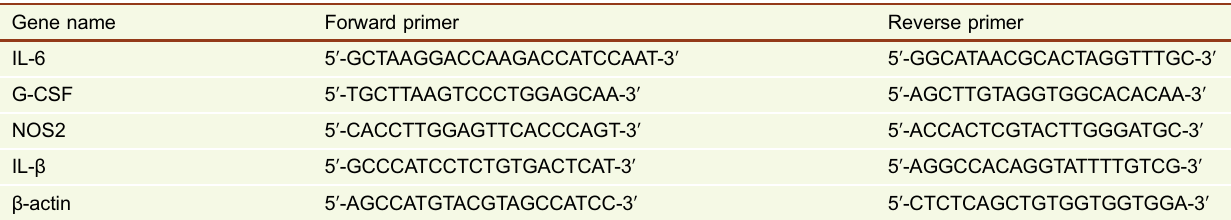
Figure 5. Anti-G-CSF treatment reduces MDSC in fi ltration and cancer formation. (A) The percentage of MDSCs in the colon or peripheral blood of anti-G-CSF mAb treated mice compared with control animal measured by fl ow cytometry. The results represent 3 independent experiments ( n = 8). (B) The appearance of colon from wild type mice, AD3 mice treated with anti-G-CSF mAb, AD3 mice treated with rabbit IgG and control mice (from top to bottom) (up). The length of colon from the four groups mentioned above (from left to right) (middle). Number of colonic tumor node from AD3 mice treated with anti-G-CSF mAb, AD3 mice treated with rabbit IgG and control mice (from left to right) (below). The results represent 3 independent experiments ( n = 3). * represents P < 0.05; P values were obtained using two-tailed Student's t tests. (C) The pro- in fl ammatory cytokine iNOS (up), IL-6 (middle), IL-1 β (below)- expression in colon after treatment with anti-G-CSF mAb (right) compared to control mice (left) by IHC. The results represent 3 independent experiments ( n =